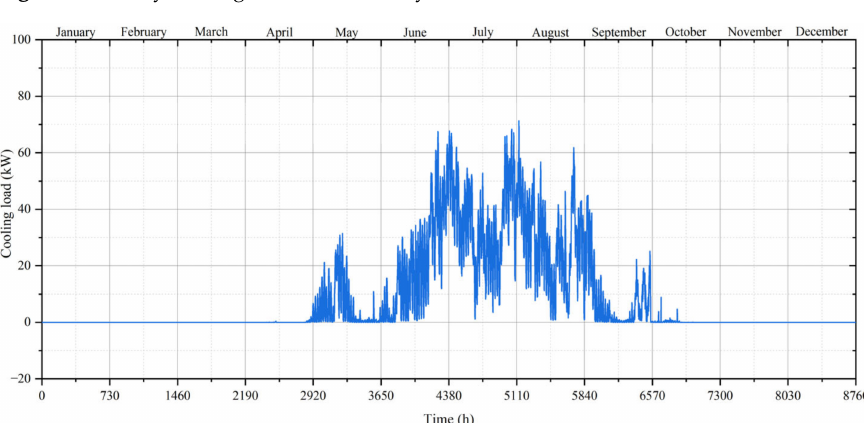
Figure 5. Hourly heating load of dormitory.